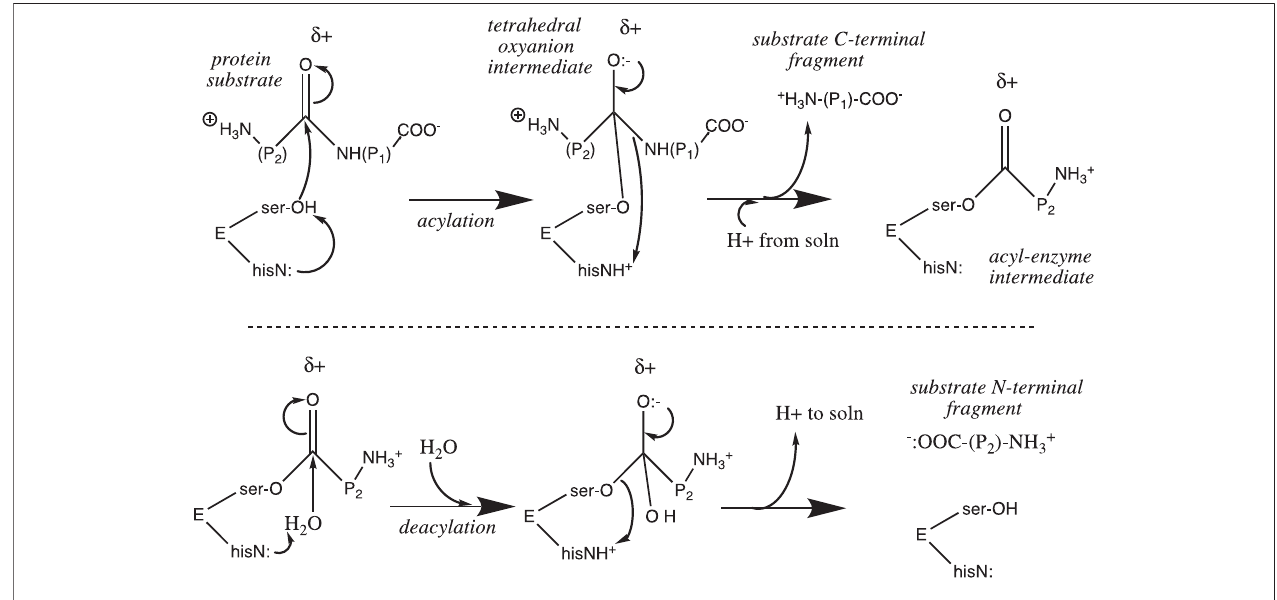
FIGURE 5 | Chymotrypsin catalytic mechanism.